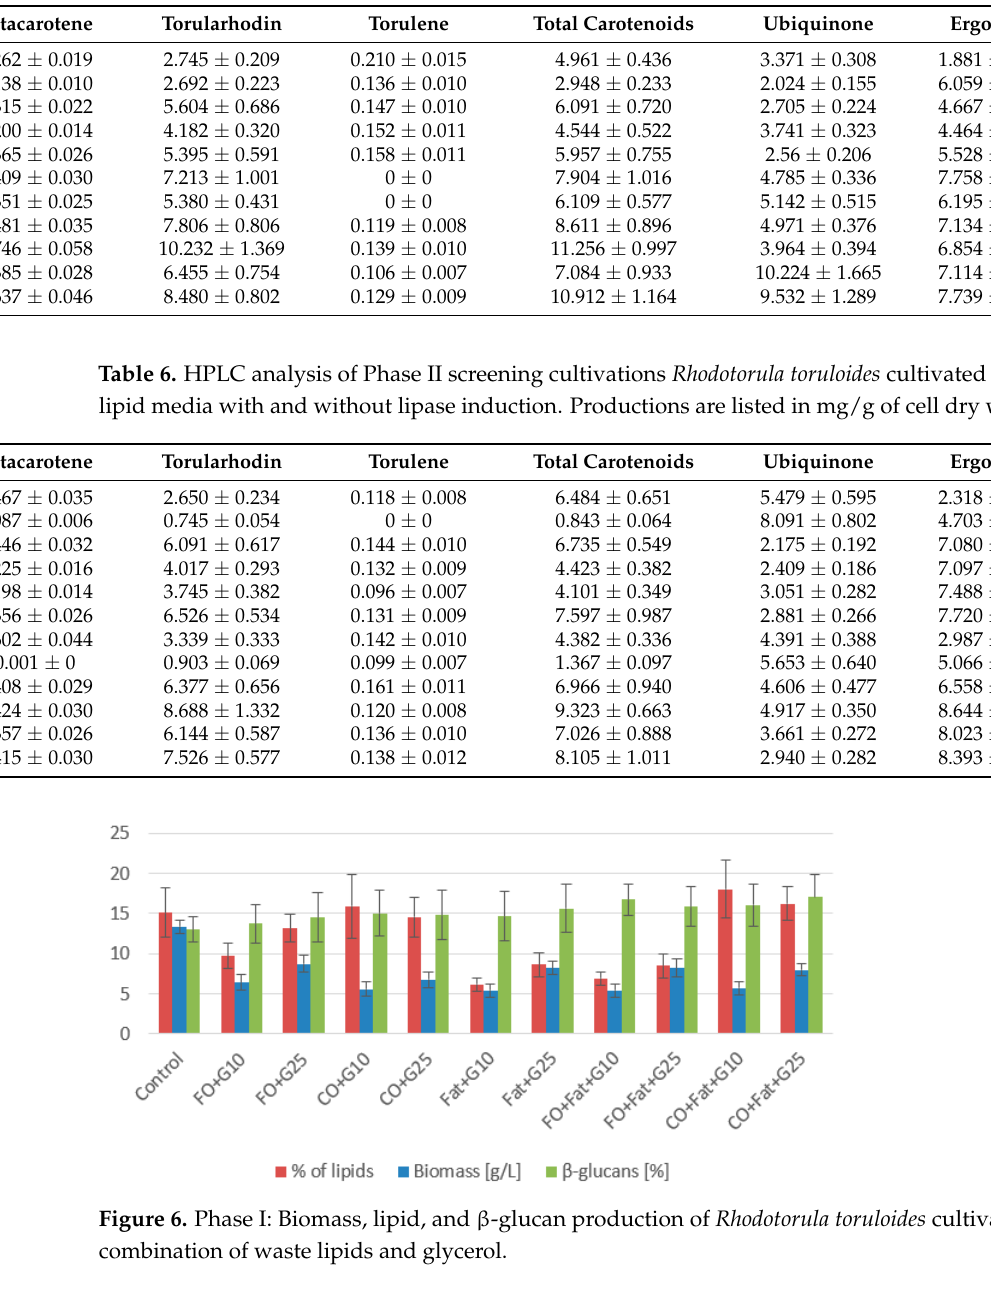
Table 5. HPLC analysis of Phase I screening cultivations Rhodotorula toruloides cultivated on a combination of waste lipids and glycerol. Productions are listed in mg/g of cell dry weight.